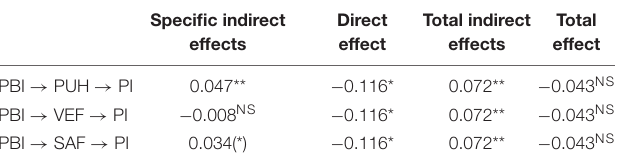
TABLE 4 | PLS regression results for the mediation